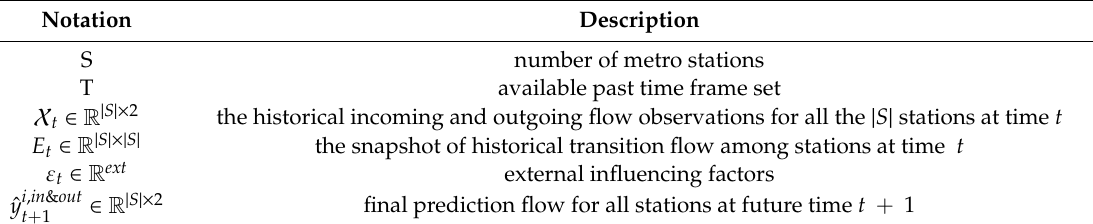
Table 1. Notation description in this